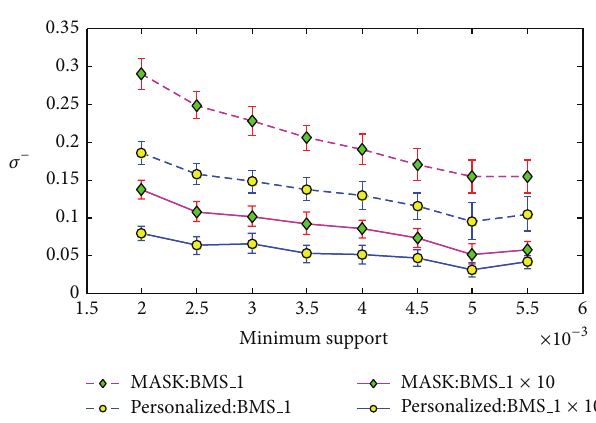
Figure 12: Frequent itemset lost ration 𝜎 − versus minimum support on different size of datasets.